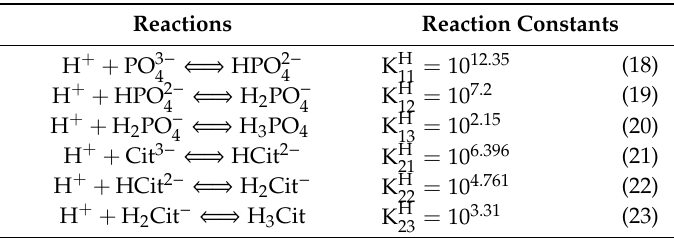
Table 5. Reactions and corresponding reaction constants.